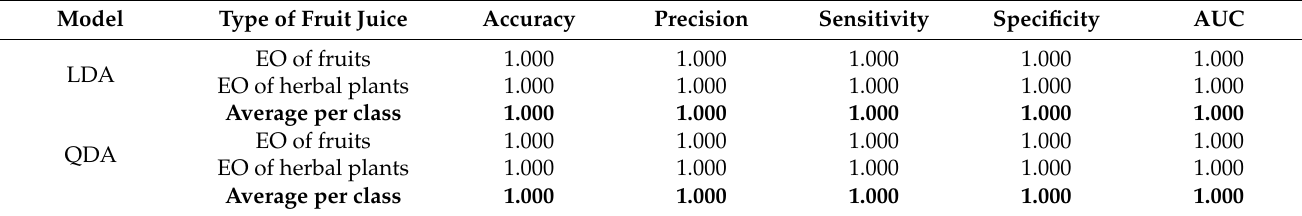
Table A1. Performance parameters of LDA and QDA statistical models for two-group classification of herbal and fruit essential